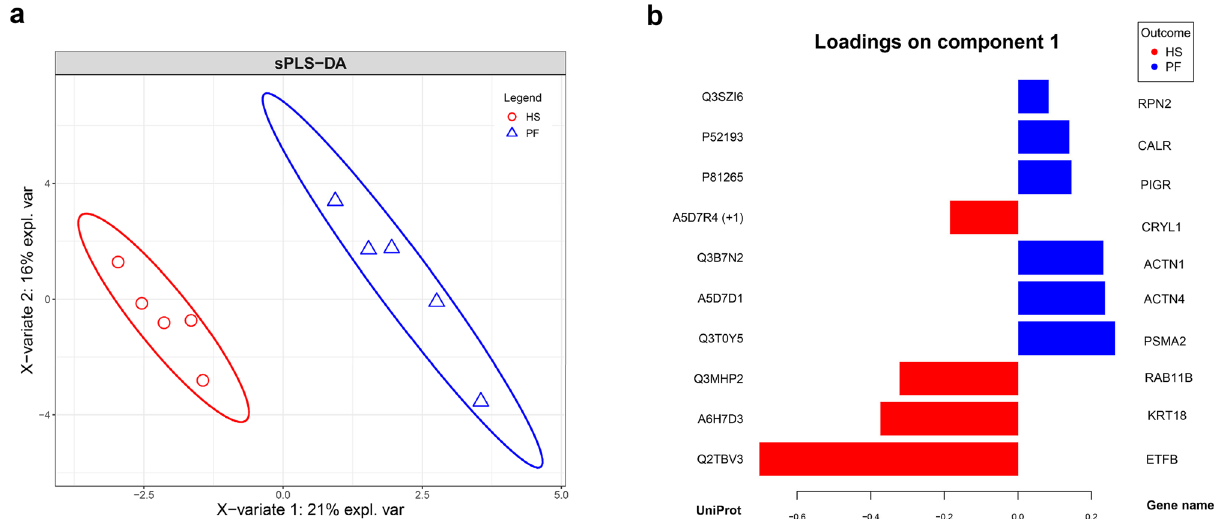
Figure 2. ( a ) Sparse Partial Least Squares-Discriminant Analysis (sPLS-DA) explains 21% of the variation 1 and 16% of the variation 2 (heat stressed (HS; red, open circles) and pair-fed (PF; blue, open triangles) dairy cows. ( b ) The loading on component one represent the main proteins behind the HS (red bars) and PF (blue bars) cluster. Graphs were created using the mixOmics package in R (version 6.1.1) 60 .